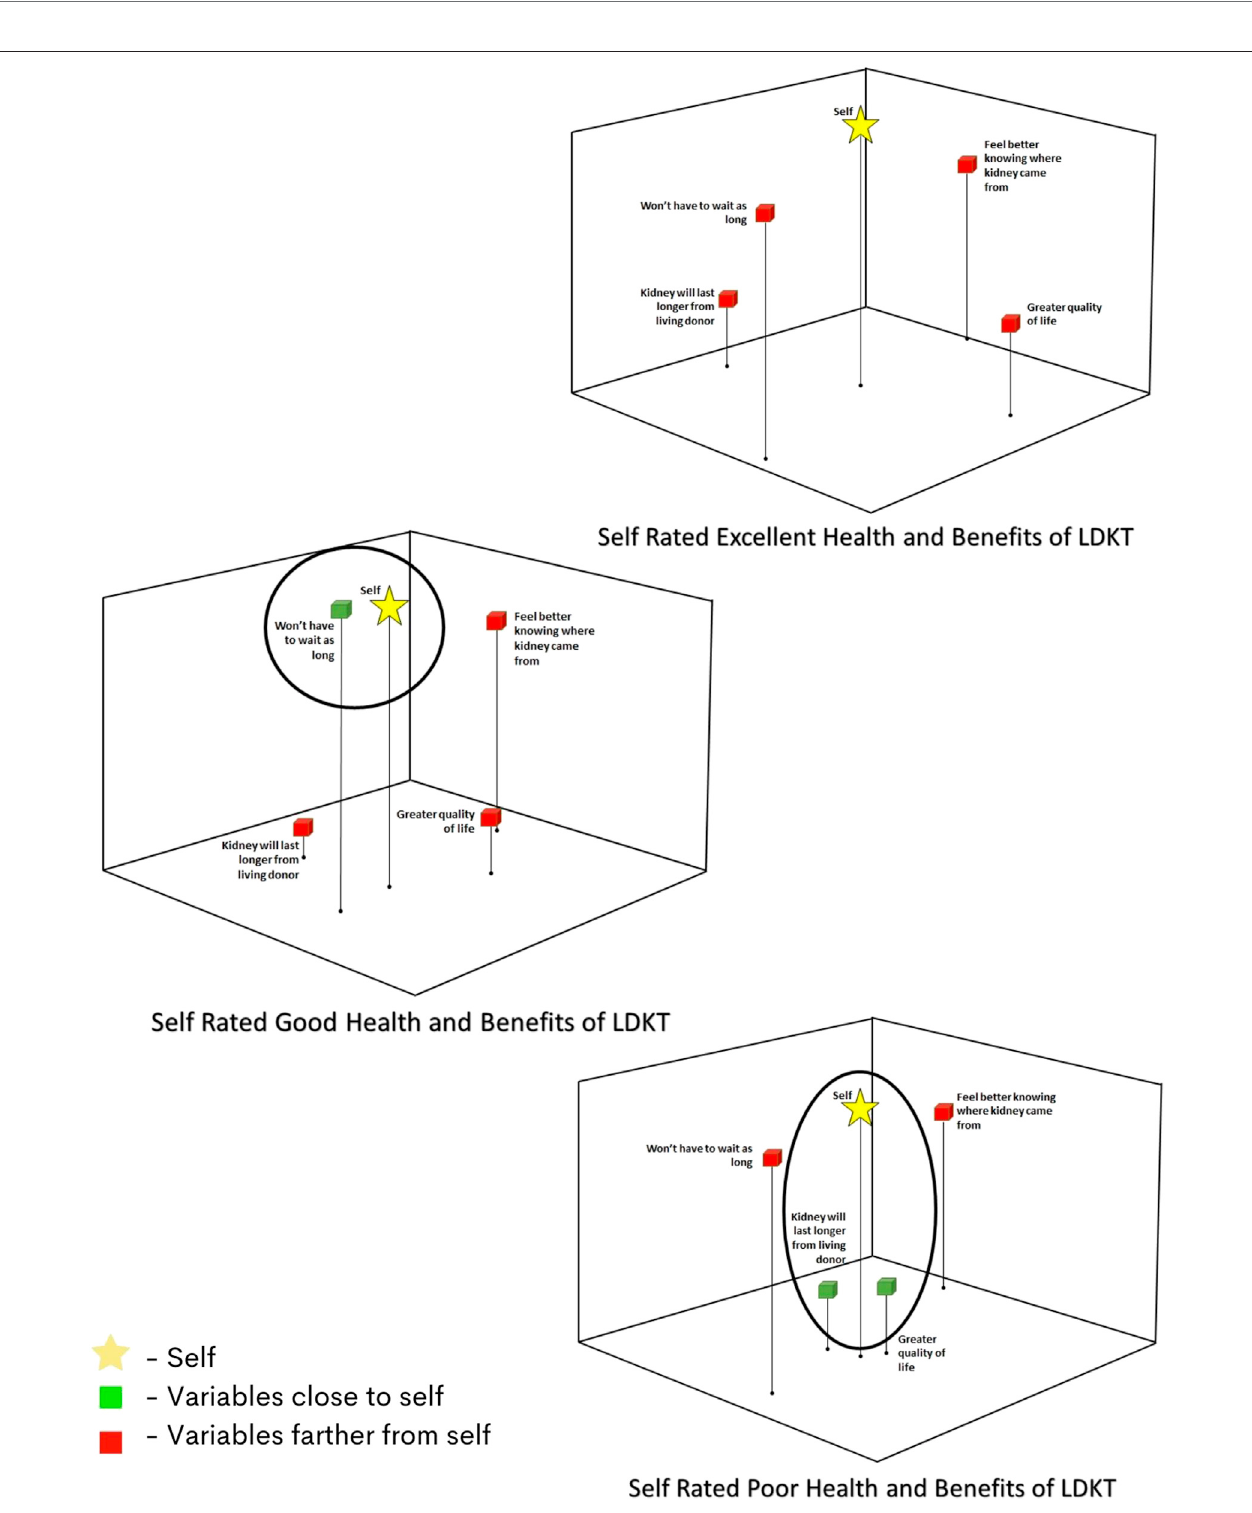
FIGURE 3 | Perceptual maps for bene fi ts of LDKT by self-reported health status.